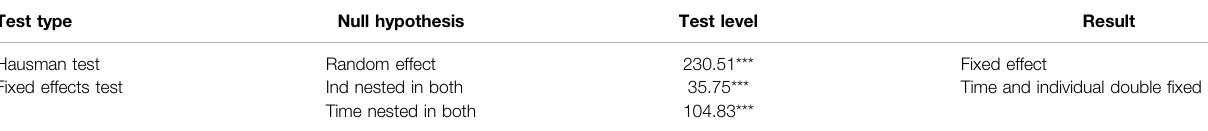
TABLE 7 | The results of the Hausman test.